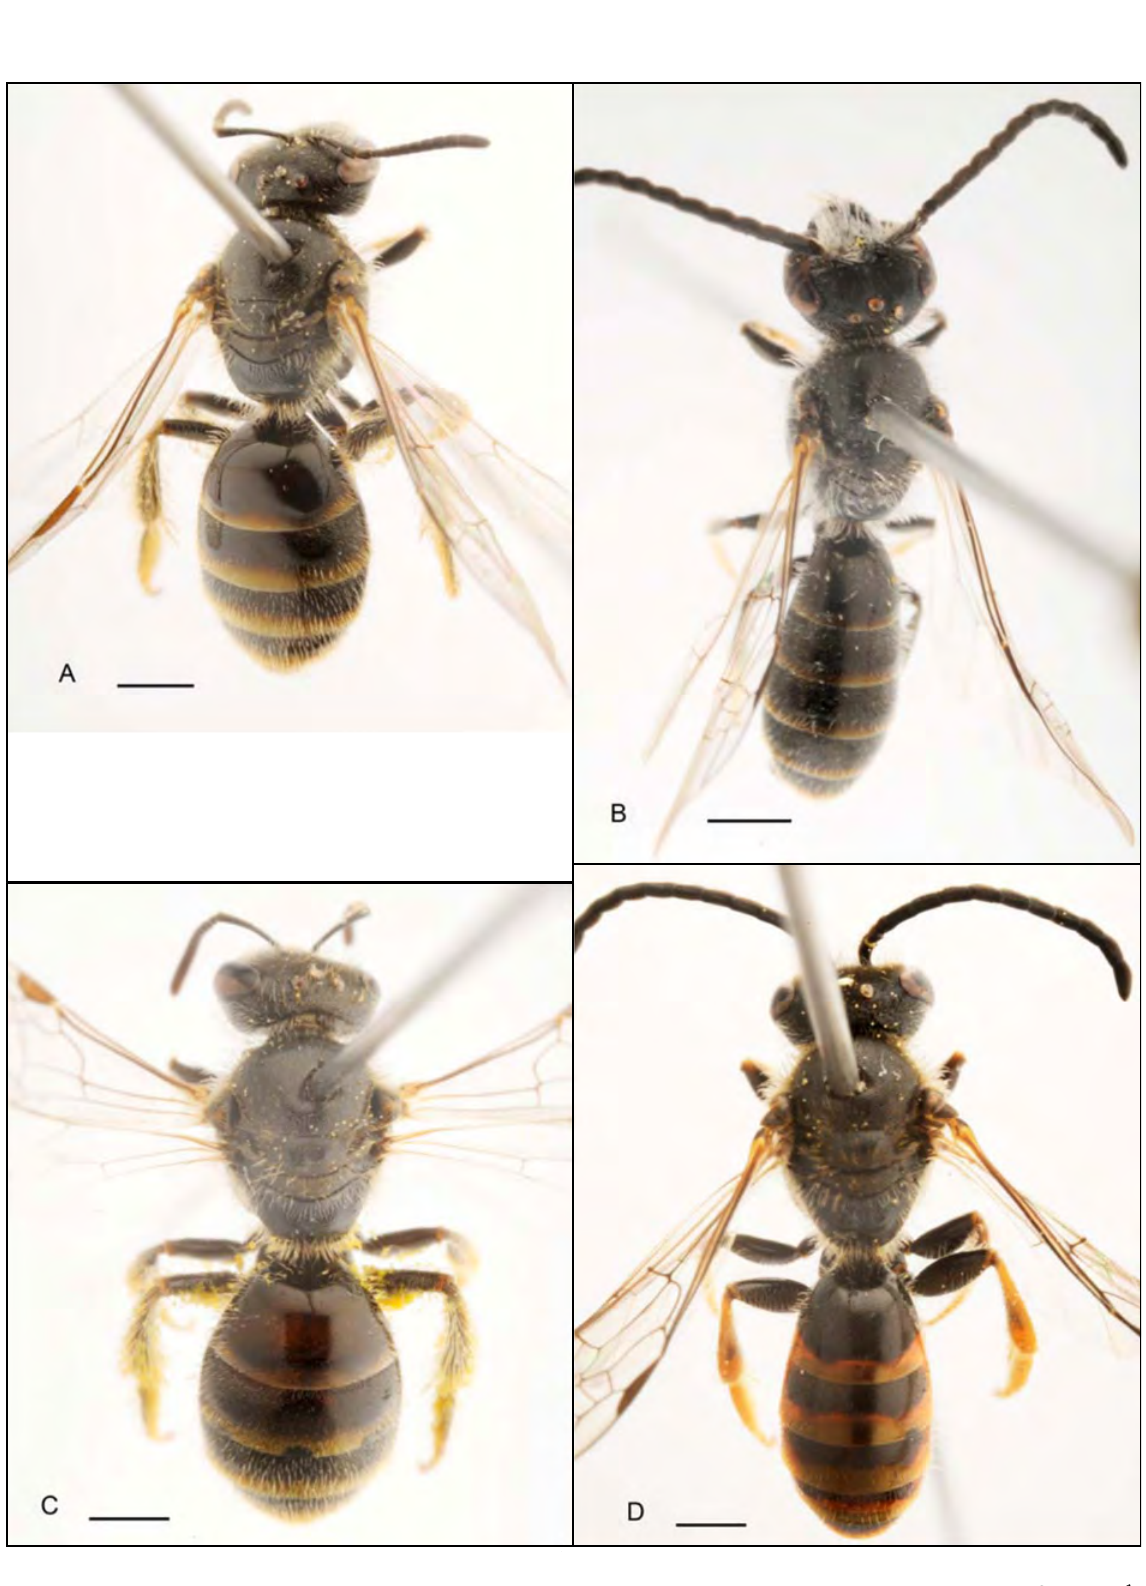
Fig. 11. Dorsal habitus. — A-B . Lasioglossum ( Capalictus ) hantamense sp. nov. . A. ♀. B. ♂. — C-D . Lasioglossum ( Capalictus ) tigrinum sp. nov . C. ♀. D. ♂. Scale line = 1